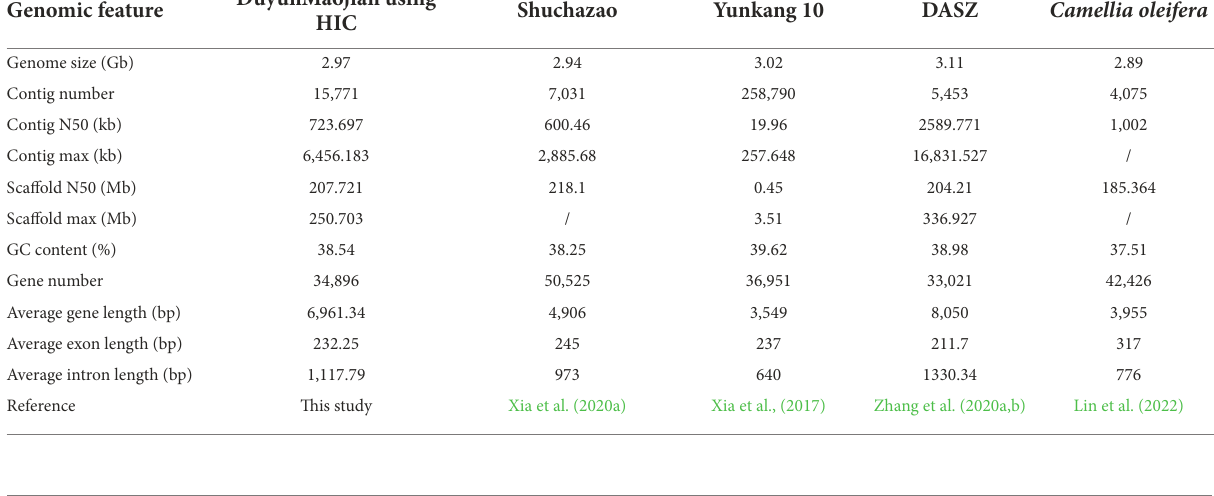
TABLE 1 Summary statistics of the DuyunMaojian tea plant assembly genome compared with those of other cultivars and species. Genomic feature